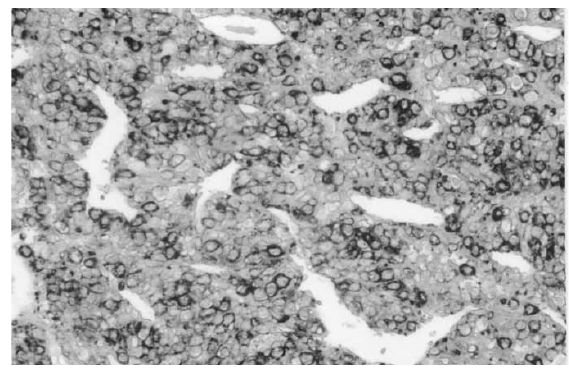
Fig. 5. The neoplastic cells present strong smooth muscle actin expression (immunoperoxidase, (cid:1)